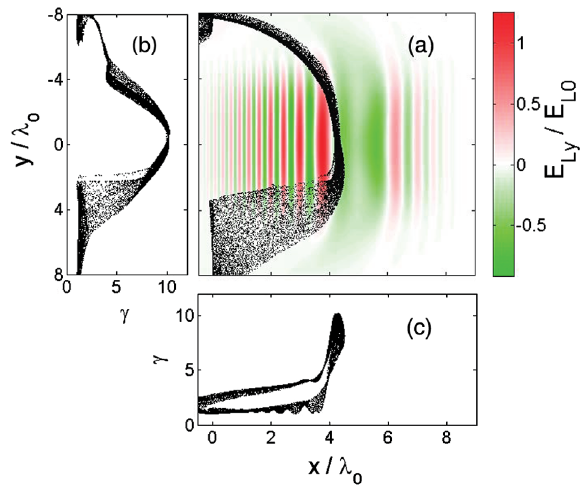
FIG. 4. The distribution of DEES driven by chirped pulse in x (cid:1) y space (a) and phase space [(b) and (c)] at t ¼ 8 (cid:3) black dots (clouds) represent the simulation particles and the colored background in (a) represents the laser